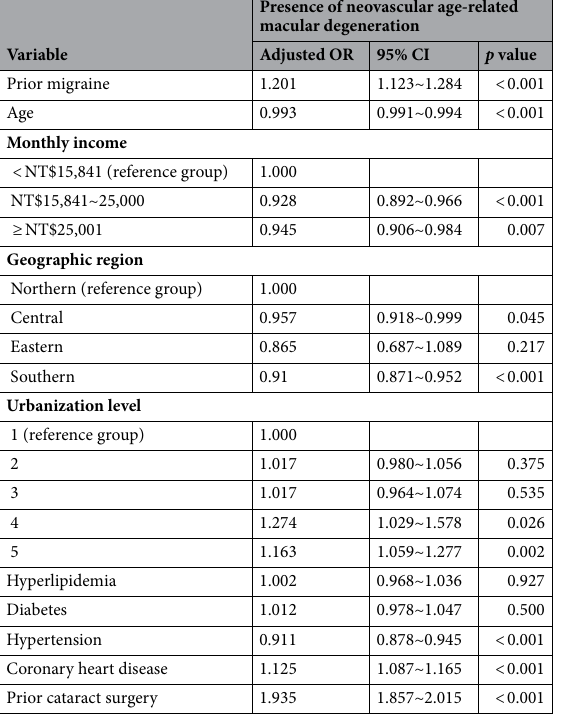
Table 2. Covariate-adjusted odds of prior migraine (OR and 95% confidence interval, CIs) among neovascular age-related macular degeneration vs. controls (n =